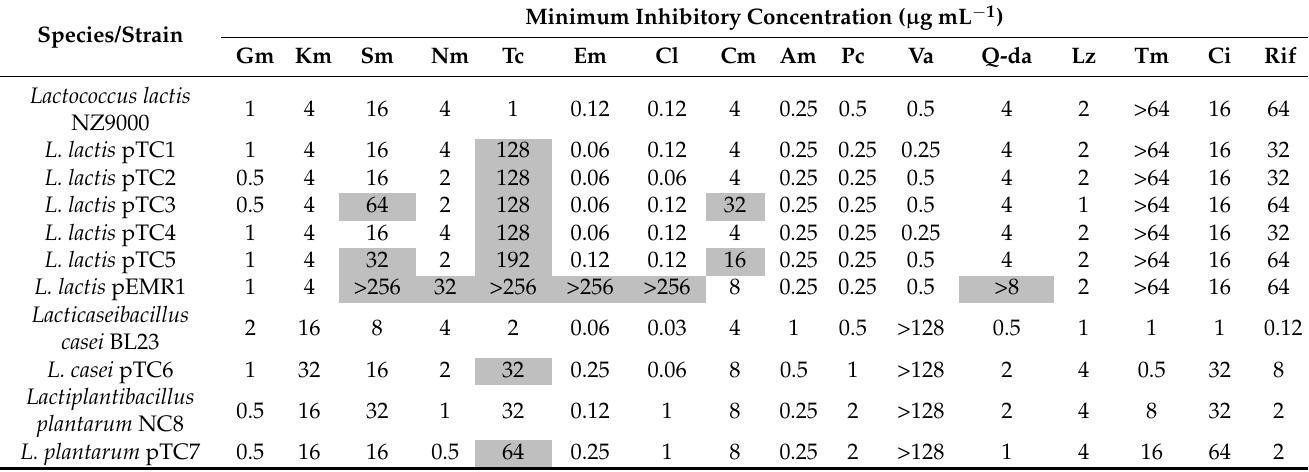
Table 1. Minimum inhibitory concentration (MIC) of 16 antibiotics to the plasmid-free Lactococcus lactis NZ9000, Lacticas- eibacillus casei LB23, and Lactiplantibacillus plantarum NC8 and their plasmid-containing transformed derivatives.